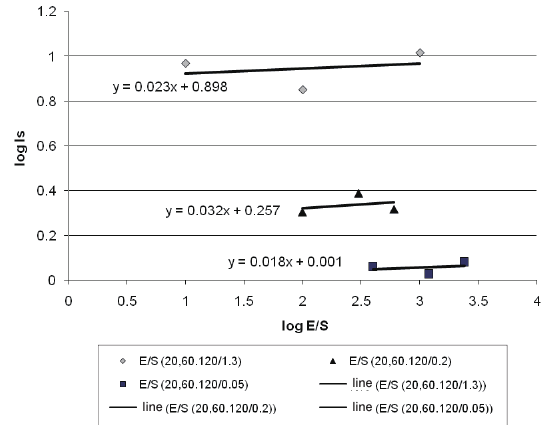
Fig. 3 Correlation of the dimensionless group S/R 2 V E log vs log 10 I s = α 1 + α 2 for three different feeding rates (0.05, 0.2 10 (cid:31) S (cid:30) · and 1.3